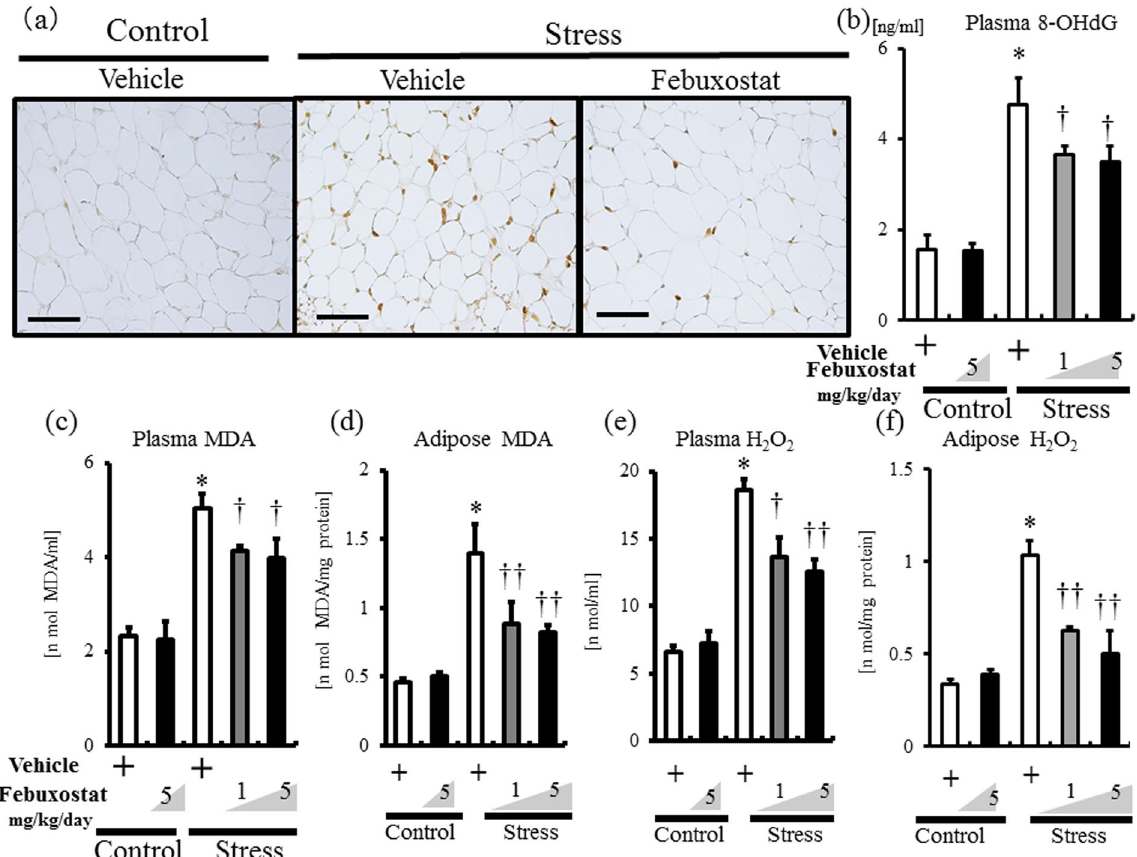
of the control (non-stressed) and stressed mice treated with or without febuxostat (1 or 5 mg/kg/day) by immunohistochemistry and ELISA, respectively. Data were analyzed by Student’s t-test and displayed as mean ± SD of 5–6 mice per group. ( a ) Representative pictures of 8-OHdG staining of adipose tissues ( × 200 magnification, bar = 50 µ m). ( b ) Plasma levels of 8-OHdG. * P < 0.001, compared with the vehicle-treated control mice, † P < 0.05, compared with the vehicle-treated stressed mice. ( c , d ) MDA in plasma ( c ) and homogenized adipose tissue ( d ). * P < 0.001, compared with the vehicle-treated control mice, † P < 0.05 and †† P < 0.02, compared with the vehicle-treated stressed mice. ( e , f ) H 2 O 2 in plasma ( e ) and homogenized adipose tissue ( f ). * P < 0.001, compared with the vehicle-treated control mice, † P < 0.002 and †† P < 0.001, compared with the vehicle-treated stressed